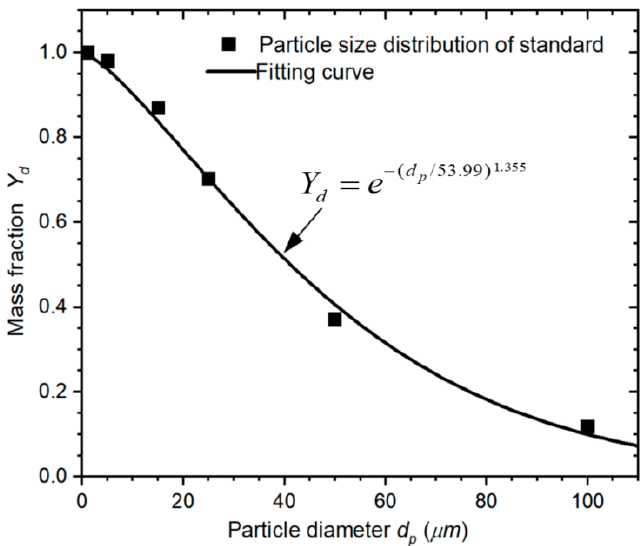
Y Figure 7. Distribution curve of Y d under level-7 contamination degree. Figure 7. Distribution curve of d under level ‐ 7 contamination degree. Table 3. Rosin–Rammler distribution parameters of Table 3. Rosin–Rammler distribution parameters of particles.